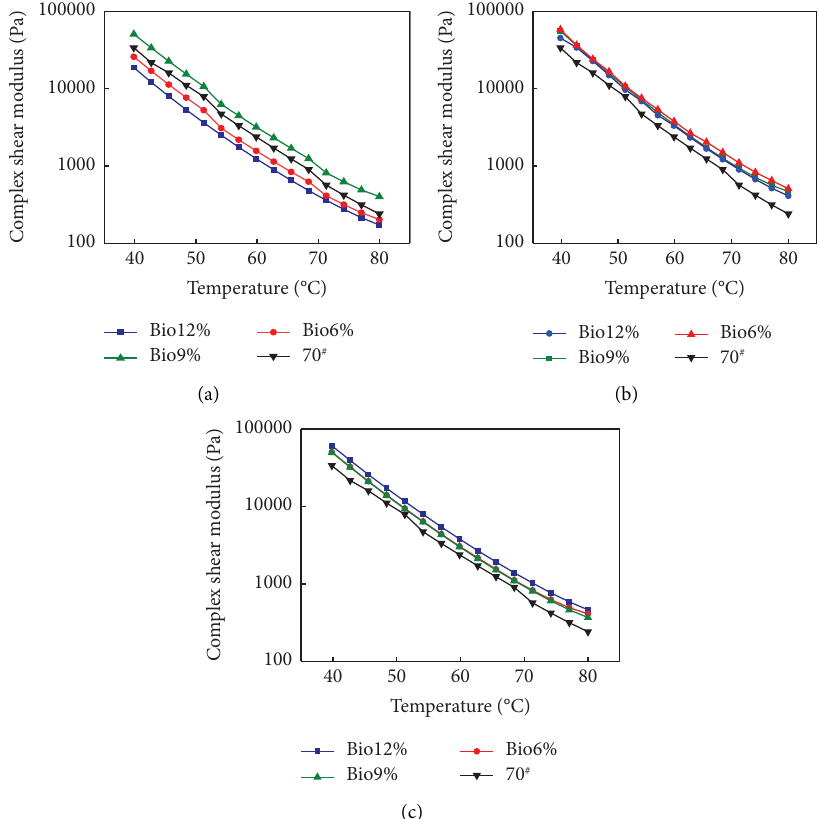
Figure 7: Te relationship between complex shear modulus and temperature: (a) 0% nano-Zno, (b) 1% nano-ZnO, and (c) 3% nano-ZnO.